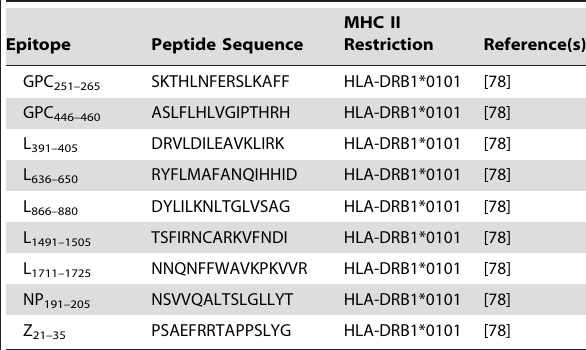
Table 2. Human HLA class II restricted epitopes against pathogenic arenaviruses.